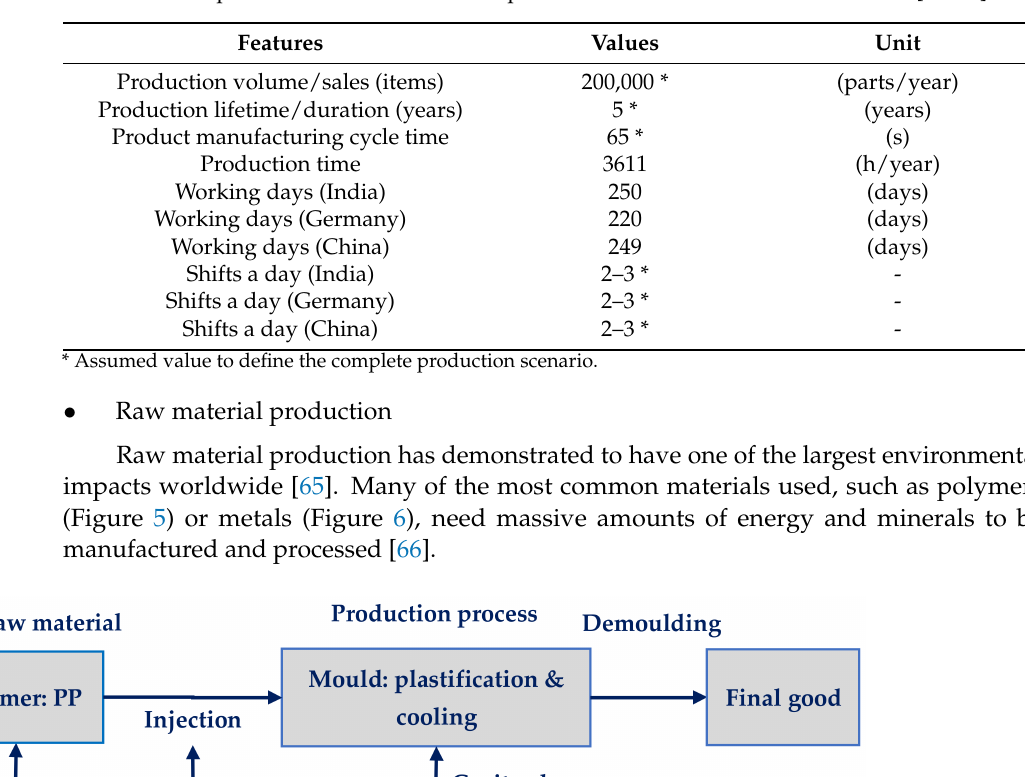
Table 14. Main product industrial scenario—production features for the business case [62–64].